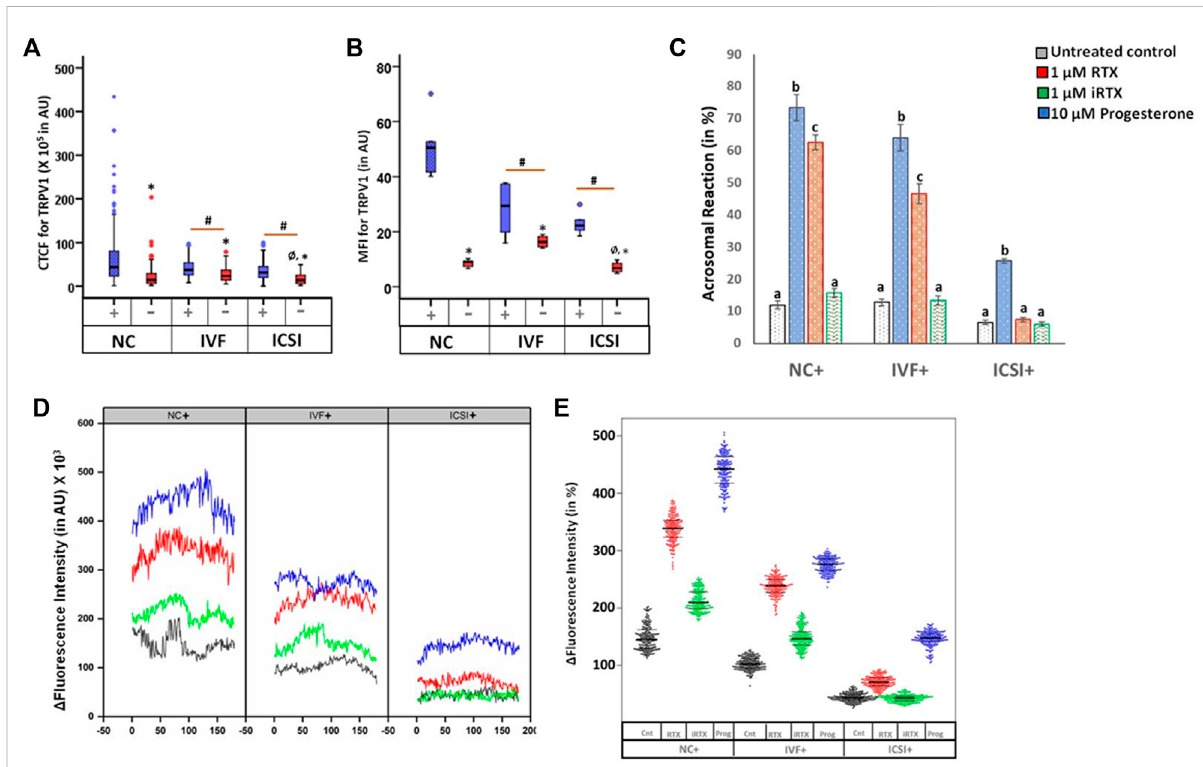
FIGURE 4 Expression pro fi le of TRPV1 in spermatozoa of male partners of couples with different pregnancy outcomes. Couples with successful pregnancybynaturalconception(NC+),byIVF(IVF+),orbyICSI(ICSI+)werecomparedtoRPLcouples(NC-),orwithfailedpregnancyafterIVF(IVF- ) or ICSI (ICSI-). (A) Box-whisker plot of corrected total cell fl uorescence (CTCF) intensity of TRPV1 in spermatozoa of different groups in arbitrary units(AU); (B) box-whiskerplotofmean fl uorescenceintensity(MFI)ofFACsanalysisshowingtheintensityofTRPV1inspermatozoaofdifferent groups in arbitrary units (AU). MFI data are expressed as geometric mean in logarithmic scale of corresponding histogram. * p < 0.01 with respect to spermatozoa of men with an unsuccessful pregnancy outcome (NC-/IVF-/ICSI-) with respect to their successful counterparts (NC+/IVF+/ICSI+); # p < 0.01 with respect to spermatozoa of NC + men; Ø p < 0.01 with respect to spermatozoa of IVF + men. (C) Percentage of spermatozoa that has undergoneacrosomereactioninpresenceofpositiveinducerprogesterone,resinferatoxin(RTX;agonistofTRPV1channel),and5 ′ iodiresinferatoxin (iRTX, antagonist of TRPV1 channel). Data having superscripts of different letters are signi fi cantly different from each other at p < 0.05. (D) Quanti fi cationofFluo-4-AMintensity(inAU)over500frames,withtheinitialvaluenormalizedat100%.Increased fl uorescenceintensityisobserved inmostcells, which declinesgraduallyovertime. (E) Trellis plotdemonstrating thatcalcium fl uctuations dueto channelactivation andinhibition was same for all the fertile males (NC+, IVF+, ICSI